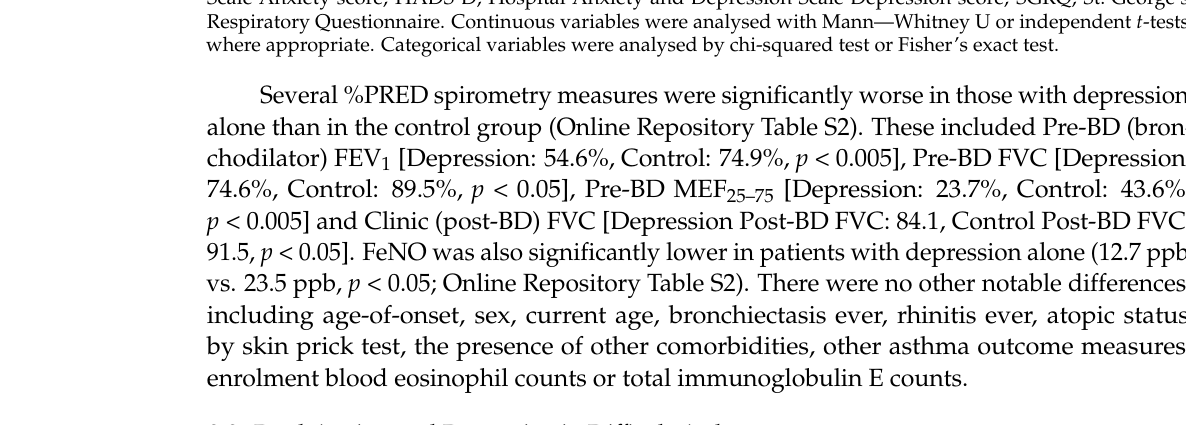
Table 2. Clinical measures of WATCH patients by clinical diagnoses of psychological comorbidity. Anxiety Alone Depression Alone ( N = 35, 6.99%) ( N = 51, 10.7%) Missing